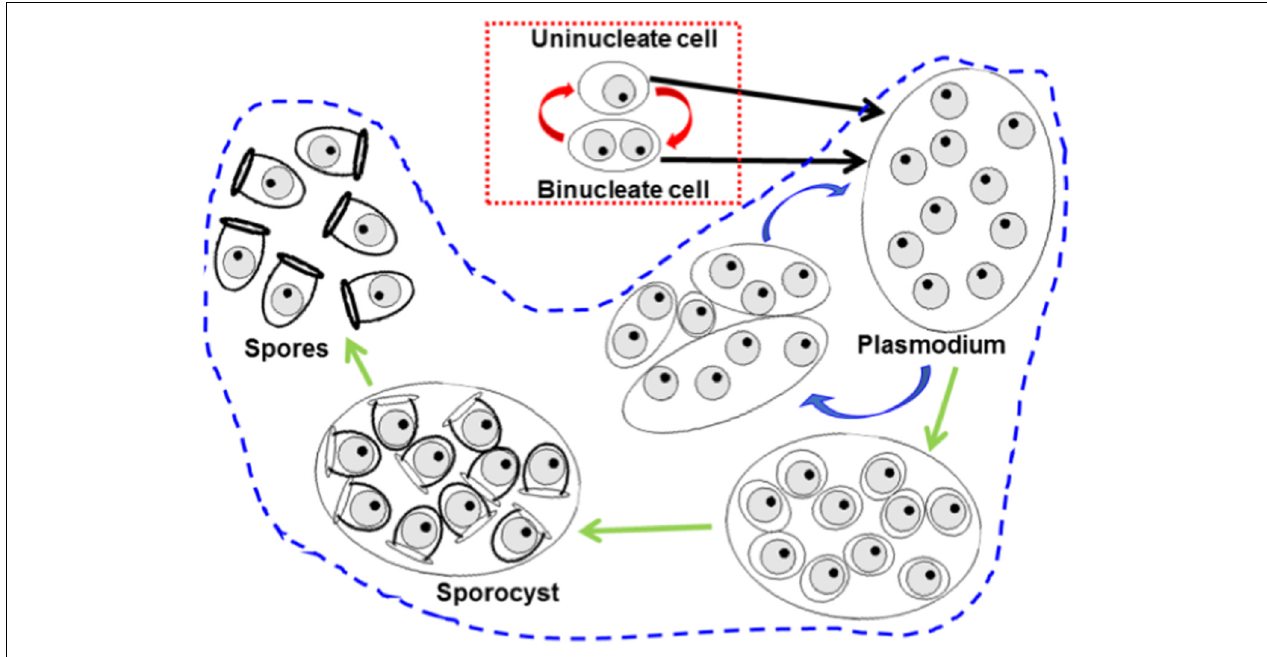
FIGURE 8 | Scheme of the known proliferation patterns trough host tissues of haplosporidan species. The red dotted frame encloses binary fission proliferation, based on karyokinesis in uninucleate cells giving rise to binucleate cells, followed by cytokinesis (red arrows). The area enclosed with blue-dotted outline includes formation of multinucleate plasmodia through karyokinesis without cytokinesis; eventually the plasmodia fragment by plasmotomy and the daughter cells repeat the process again and again (blue arrows); under unknown stimuli, plasmodia enter in sporogony process (green arrows) yielding uninucleate spores.